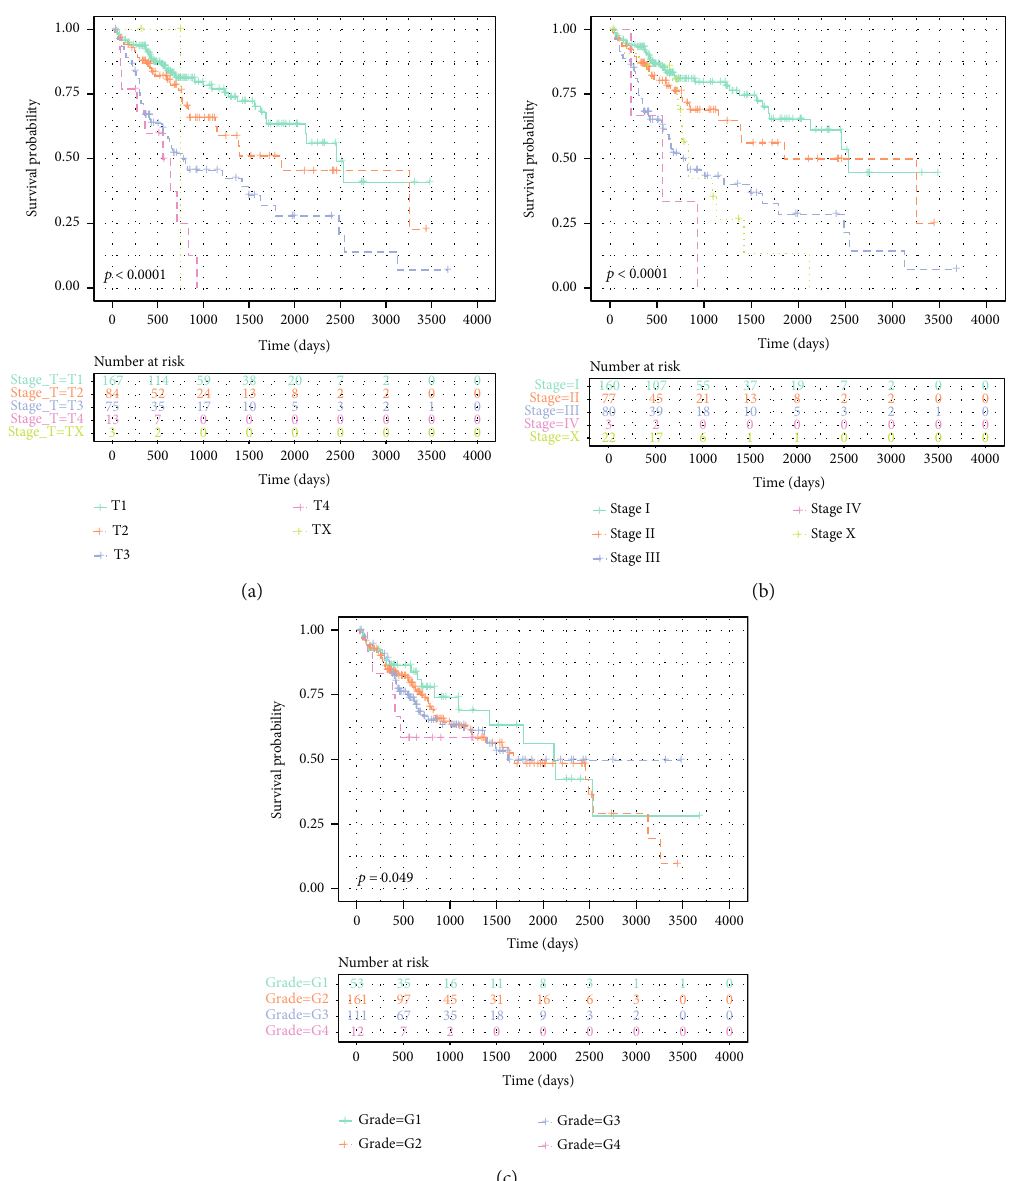
Figure 5: Kaplan – Meier survival analysis of the clinical classi fi cation (T, stage, and grade) based on the nine-IRGP signature. The survival analysis in (a) T, (b) stage, and (c)